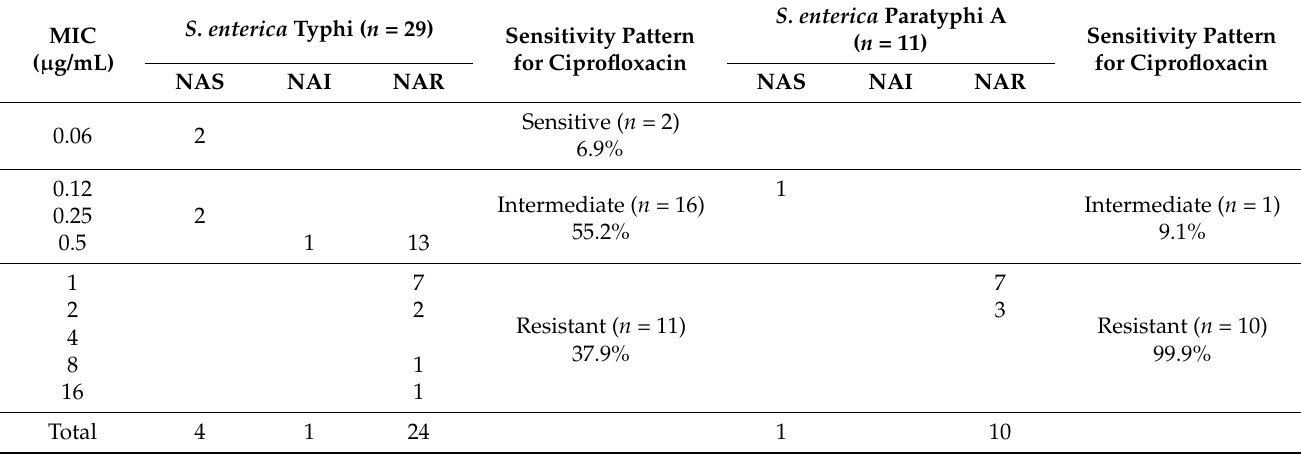
Table 5. MIC of ciprofloxacin and nalidixic acid screening test for S. enterica Typhi and S. enterica Paratyphi A. MIC ( µ